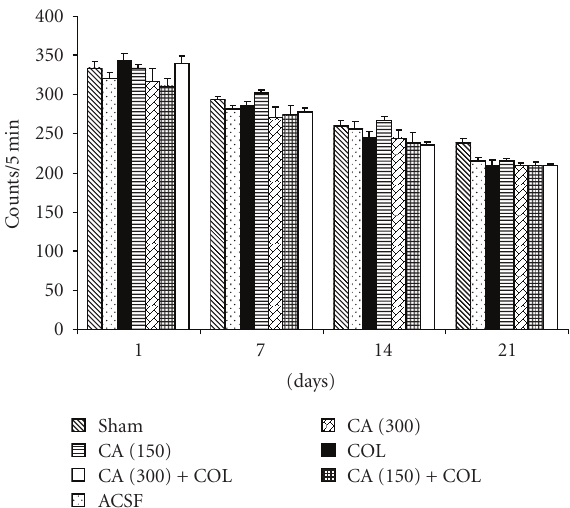
Figure 1: Centella asiatica (CA; 150 and 300mg/kg, PO) on locomotor activity in intracerebroventricular colchicines- (COL-) injected rats. Values are mean ± SEM. Data was analyzed by two- way anova ( n = 12 in each group).